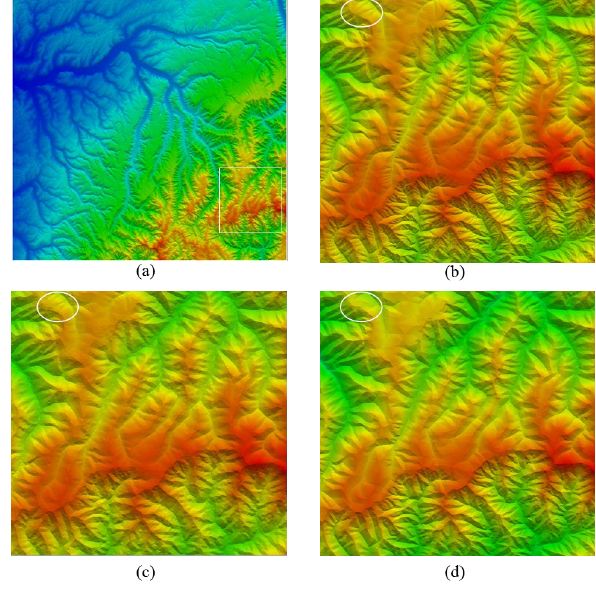
Figure 15. Detail loss from the HFPR method in the UTM11 dataset. The inspection area in the entire experimental site (a) . The magnified view of the inspection area is shown on the original dense DEM (b) , on the cCVT-generalised TIN (c) , and on the HFPR- generated TIN surface (d) . The fold morphology in the white ellipse was recovered by the cCVT method but not by the HFPR